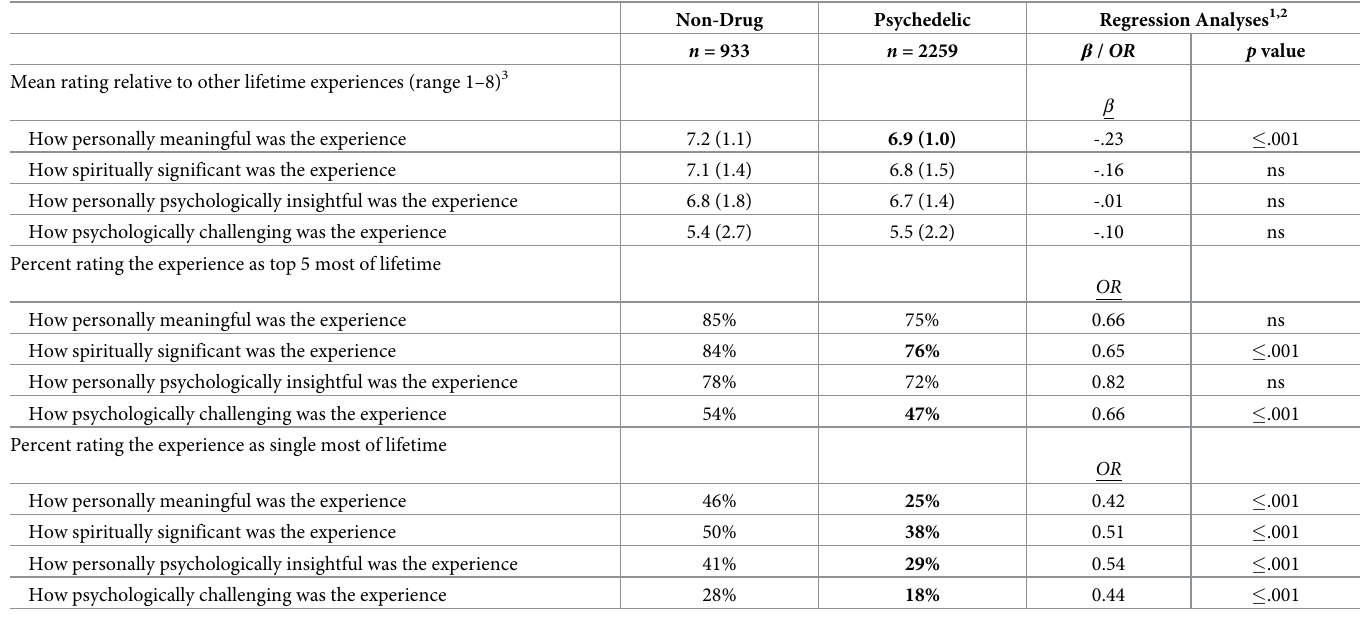
Table 9. Comparison of experience relative to other lifetime experiences among the Psychedelic Group and the Non-Drug